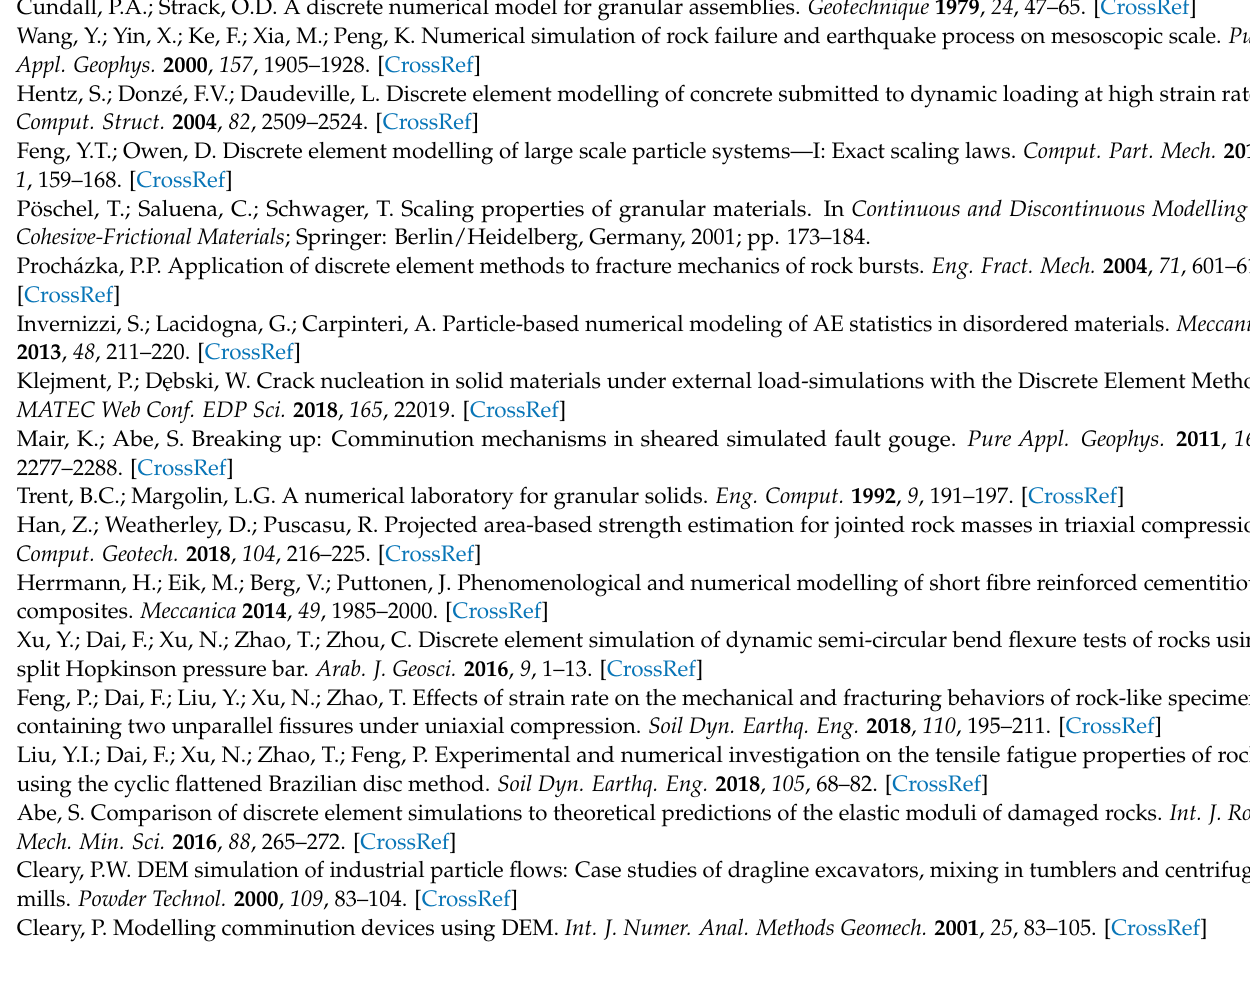
Figure A8. Surface dot-plot and model fit of calibration relationship between measured unconfined compressive strength at different beam cohesive strengths and internal angle of frictions.